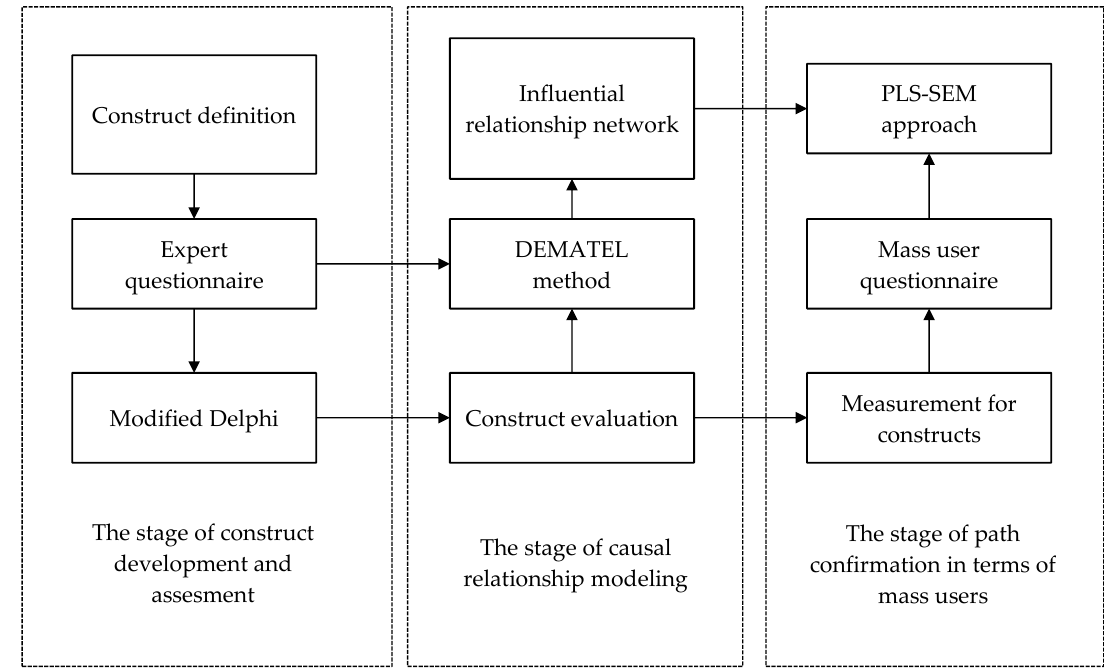
Figure 1. Analytical procedure of the proposed work.